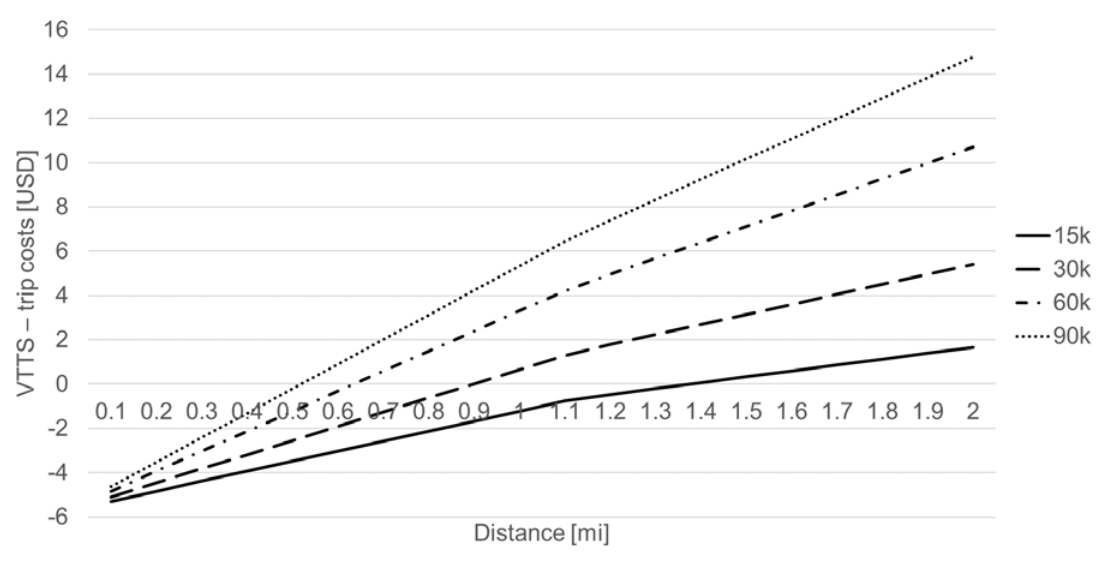
Figure 3. Difference between value of travel time savings and ridesourcing costs at different household incomes. Negative values are hypothesized to deter from the use of ridesourcing as a first/last mile feeder. As argued above, the VTTS are lower than trip costs for any distance below ~1 mi for